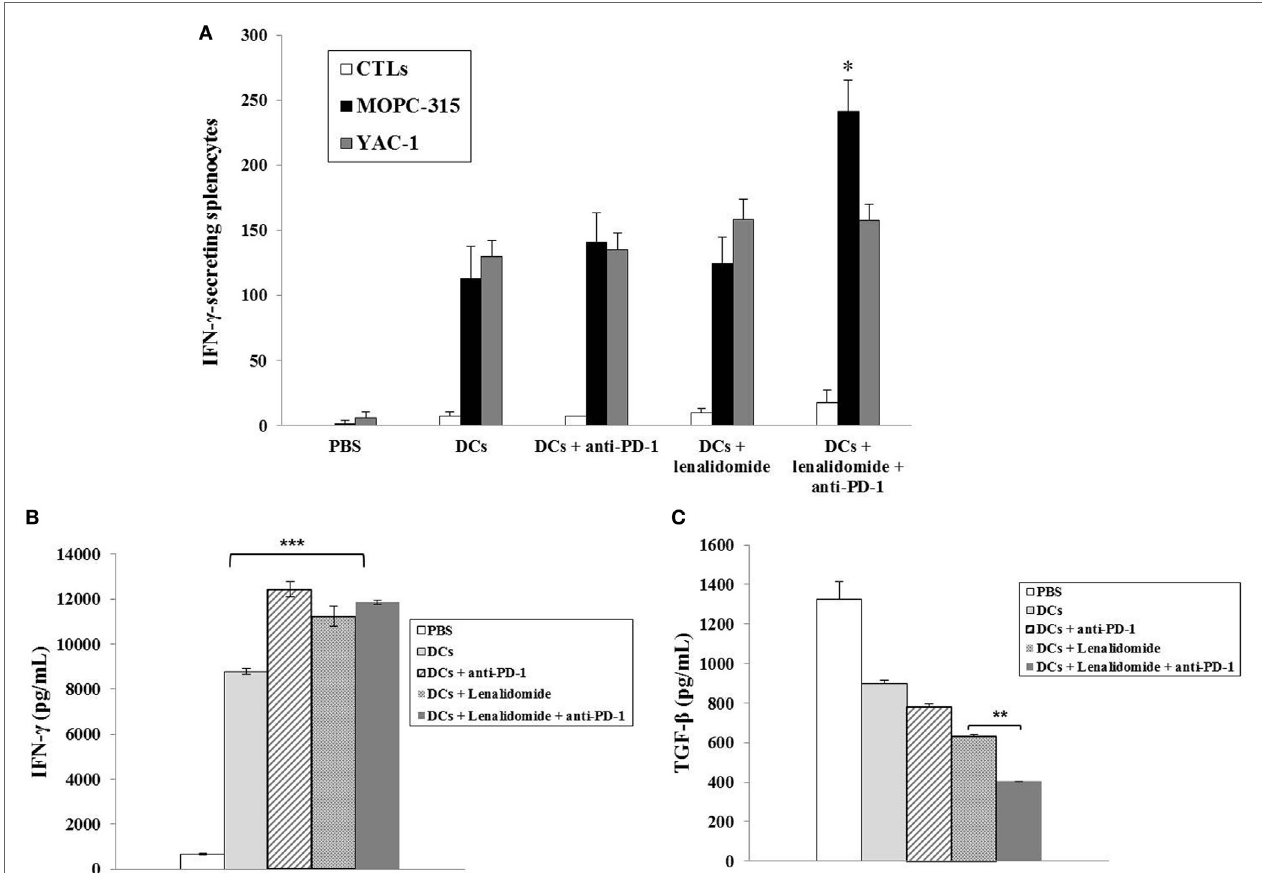
FigUre 2 | Activation of cytotoxic T lymphocytes (CTLs) and cytokine production induced by treatment with dendritic cells (DCs) plus lenalidomide and anti-PD-1. (a) The number of IFN- γ -secreting lymphocytes in the spleens of mice treated with PBS, DCs, DCs plus lenaldiomide, DCs plus anti-PD-1, and DCs plus lenalidomide and anti-PD-1 was counted using IFN- γ enzyme-linked immunospot assay. DC vaccination combined with lenalidomide and anti-PD-1 injection significantly increased the number of IFN- γ -secreting lymphocytes targeting MOPC-315 cells compared to the other groups (* P < 0.05). Cytotoxicity by natural killer (NK) cells, represented by the number of IFN- γ -secreting splenocytes against YAC-1 cells, was similar in all DC groups. These results indicate that the tumor inhibitory effects of DCs plus lenalidomide and anti-PD-1 resulted from the CTL-mediated response rather than the NK cell-mediated response. (B) IFN- γ and (c) TGF- β production in the splenocytes of vaccinated mice was evaluated by enzyme-linked immunosorbent assay. The combination of DCs plus lenalidomide and anti-PD-1 led to the production of higher levels of IFN- γ compared to PBS control and DC vaccination (*** P < 0.001). By contrast, TGF- β production by DCs plus lenalidomide and anti-PD-1 was lower compared to the other groups (** P < 0.012). Data are shown as mean (pg/mL) ± SD of triplicate cultures from three independent